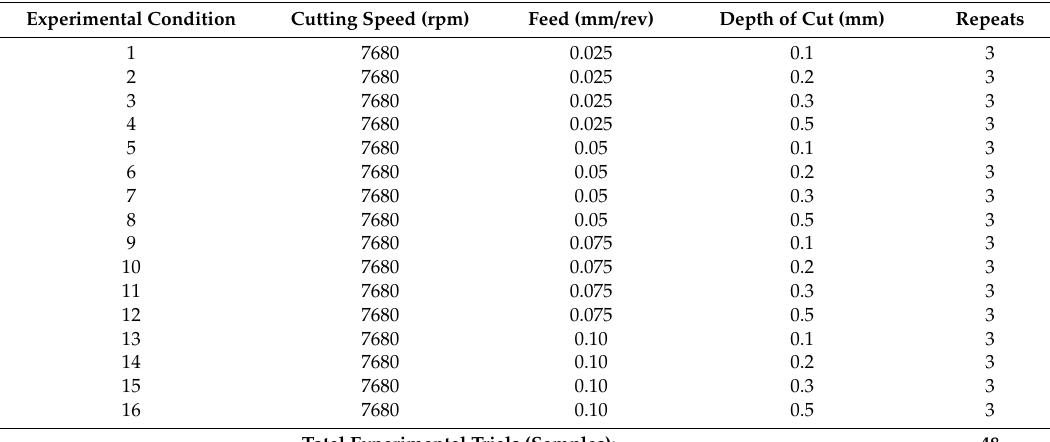
Figure 1. The Haas Milling Machine used for running the experiments. Table 2. Experimental matrix for each tool type (1/32 Uncoated, 1/32 TiN- and 1/32 TiAlN-coated carbide tool).